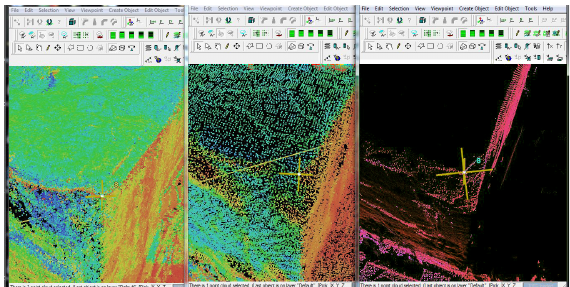
Figure 15: The registration procedure on Cyclone with manual target for the overlapping of the UAVs and TLS